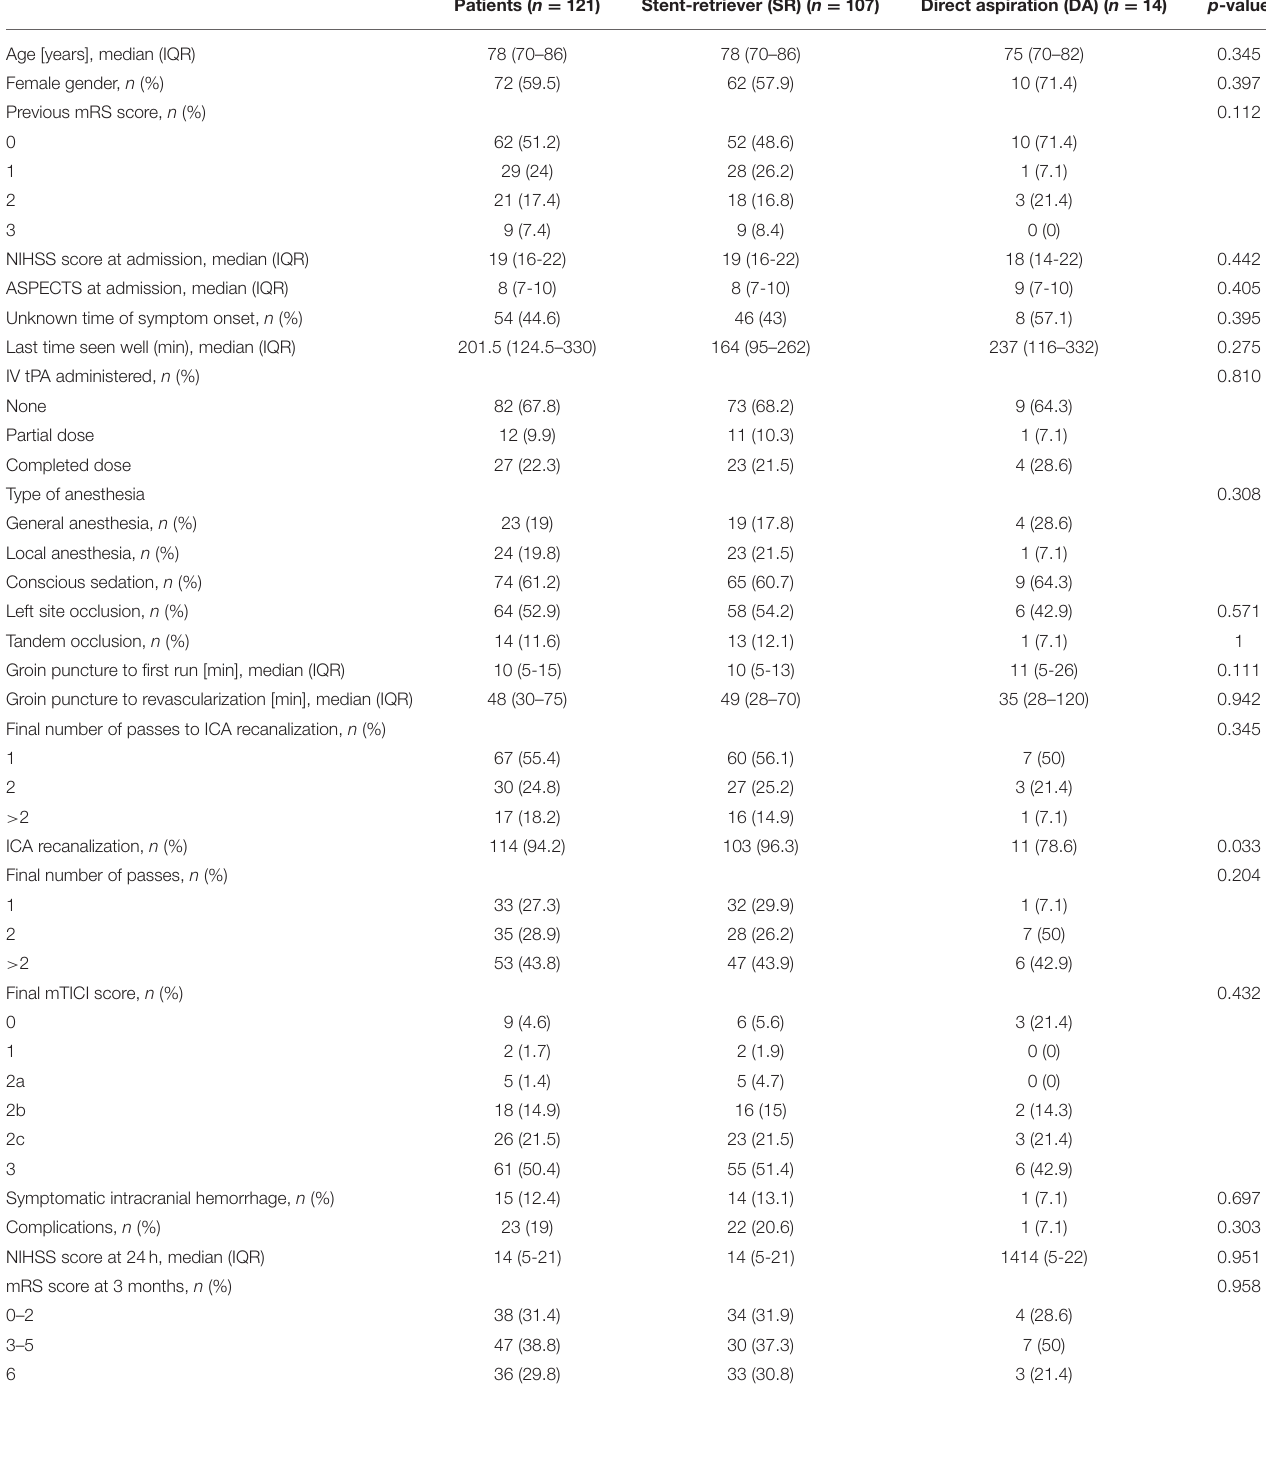
TABLE 1 | Demographic, clinical, radiological, and procedural data. Patients ( n = 121) Stent-retriever (SR) ( n =